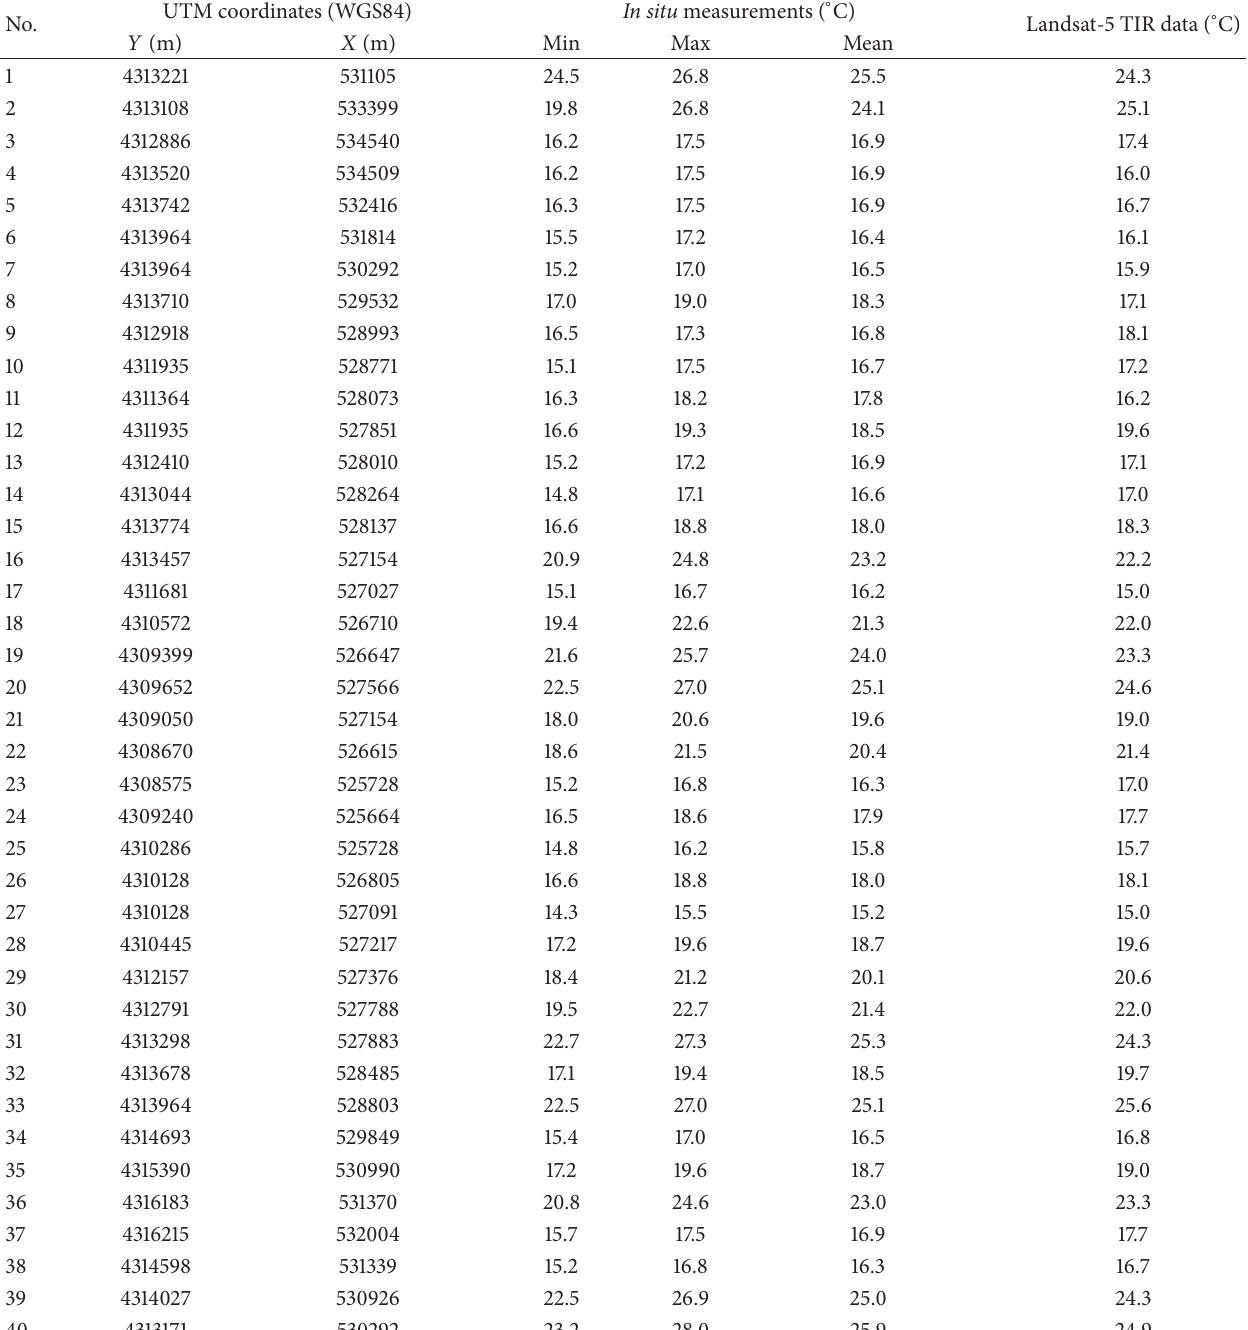
Table 2: Real-time infrared thermometer ( in situ ) measurements collected on August 21, 2011 and converted Landsat-5 thermal infrared data. UTM coordinates No.